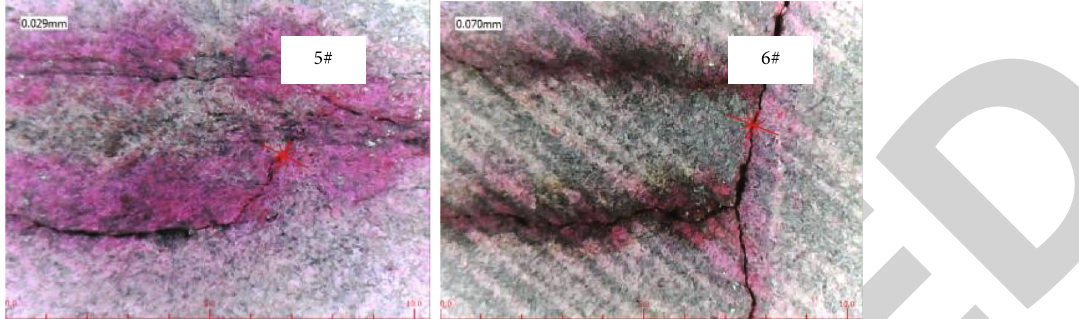
Figure 17: CT scanning images of super fi cial carbon dioxide fracturing.